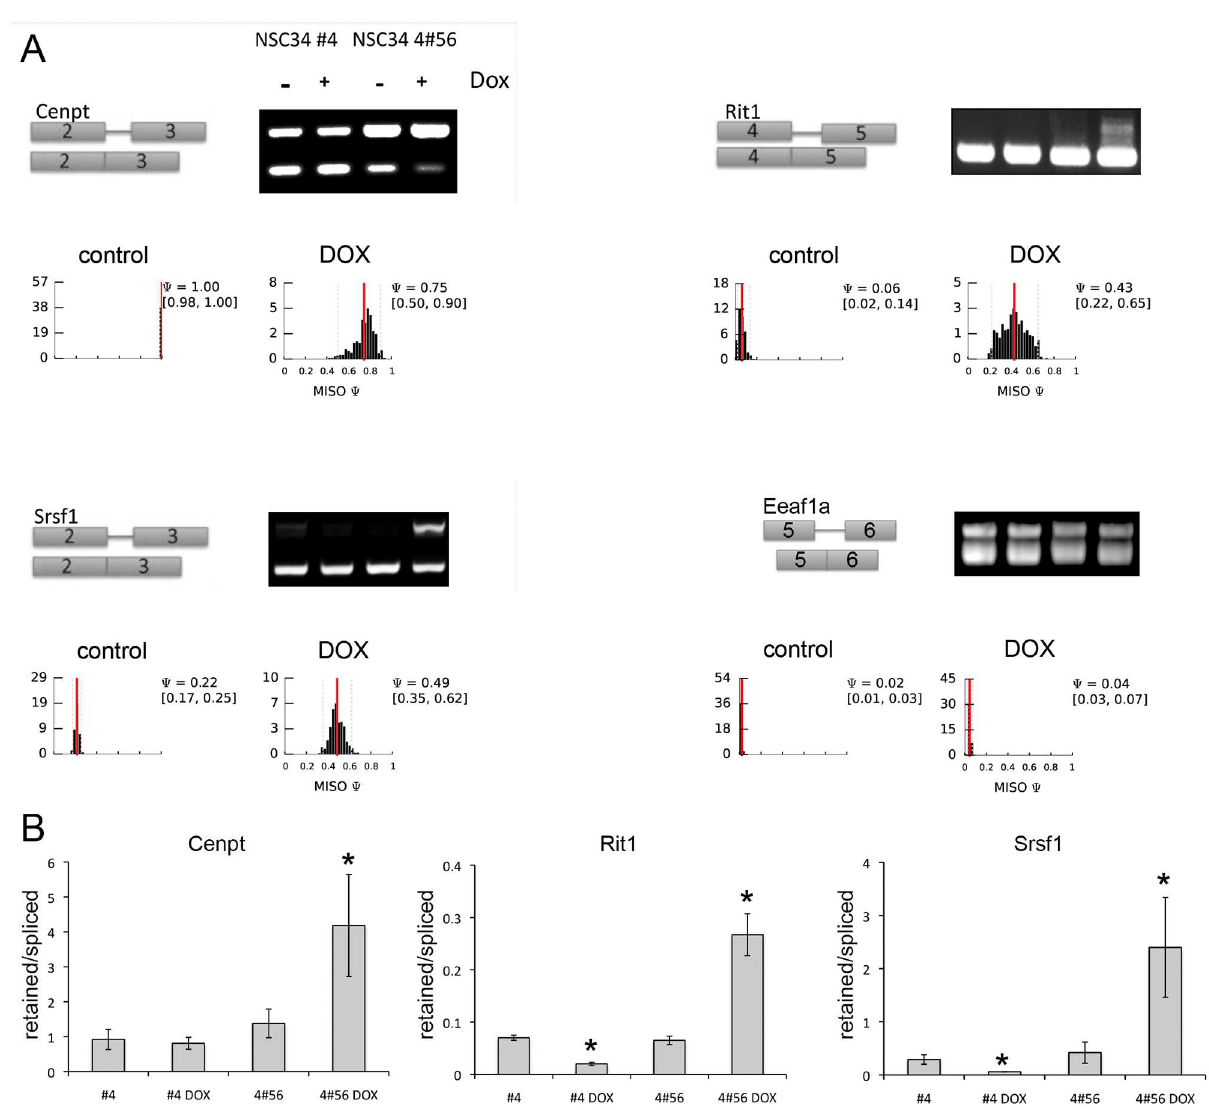
Fig 3. SMN depletion results in alternative intron usage. A) RT-PCR demonstrated increasedintron retention events in doxycycline treated NSC-34-4#56, but not NSC-34-4. The histograms show the posterior distributions over PSI estimated by MISO in control or SMN- depleted samples conditions. The red lines depict the posterior mean and the dotted grey lines indicate 95% confidence intervals (also shown in parenthesis). B) Quantification of RT-PCR band intensity from 3 biologicalreplicatesshows increasedintron retention after SMN depletion,but not after doxycycline treatment of NSC-34-4. * – p < 0.01.One-way ANOVA followedby post-hoc